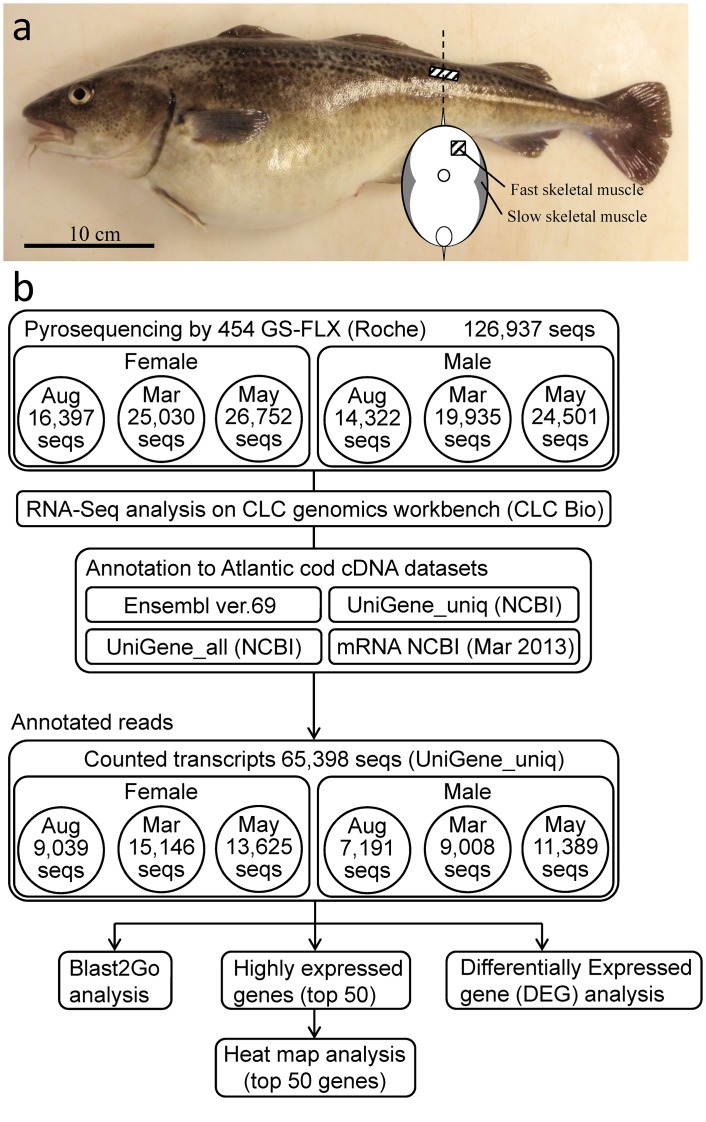
(a) Sampling positon of fast skeletal muscle and (b) schematic representation of the data processing pipeline for annotation, gene ontology, heat map, and differential expression analyses of Atlantic cod fast skeletal muscle transcriptomes for both sexes throughout the year.